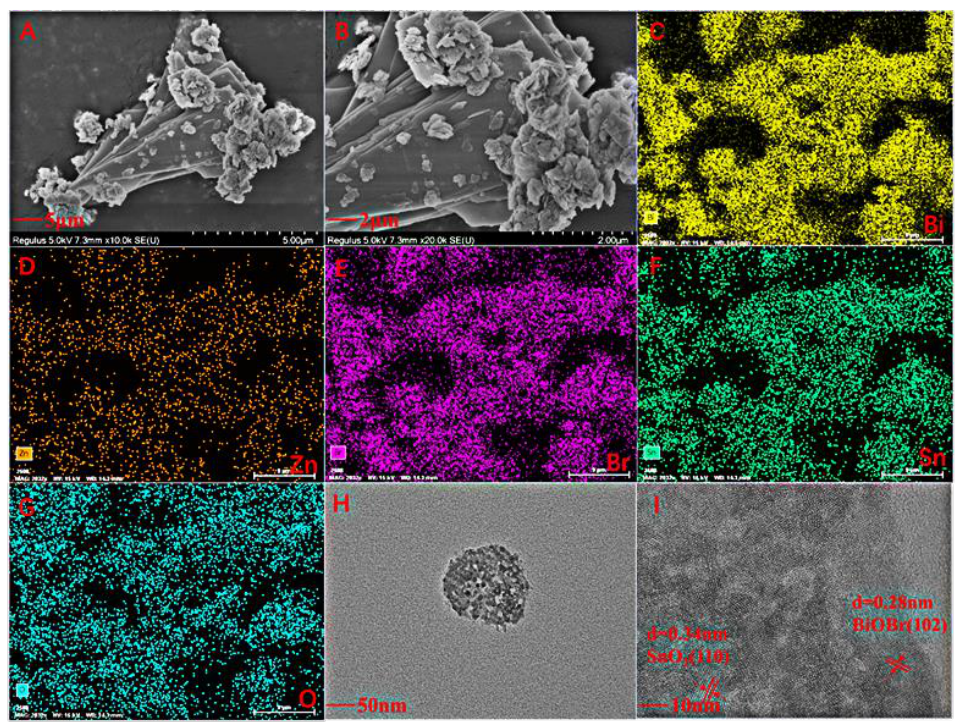
Figure 1. SEM images of BiOBr/Zn@SnO 2 ( A , B ). EDS elemental images of Bi ( C ), Zn ( D ), Br ( E ), Sn ( F ) and O ( G ). TEM images ( H ) and HRTEM images ( I ) of BiOBr/Zn@SnO 2 . The chemical structural aspects of BiOBr, BiOBr/SnO 2 , and BiOBr/Zn@SnO 2 are in-